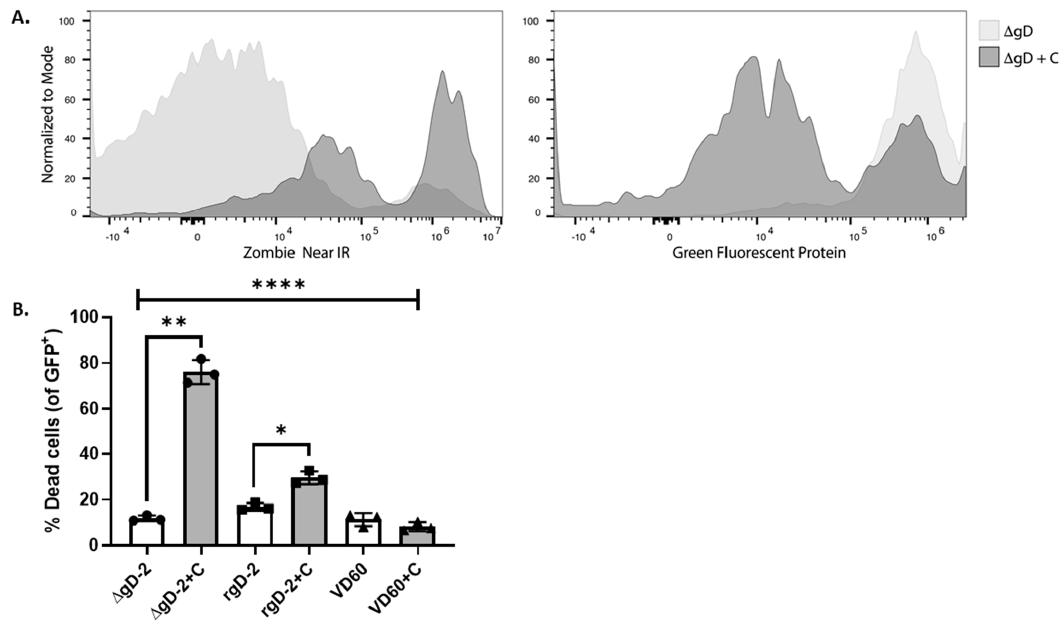
Figure 3. ∆ gD-2 immune serum activates complement-dependent cytolysis. HaCAT cells were infected with HSV- 2(333)ZAG, which expresses GFP, and then incubated for 4 h with heat-inactivated serum (1:50 dilution) obtained from mice prime-boost vaccinated with ∆ gD-2, adjuvanted recombinant gD-2 (rgD-2), or VD60 control cell lysate with or without the addition of rabbit complement (+C). Cells were stained with Zombie NIR live-dead marker, fixed and then analyzed using flow cytometry to quantify the percentage of infected (GFP+) dead cells. ( A ) Representative histogram showing GFP staining (right) and Zombie NIR live/dead staining (left) when infected cells were incubated with Δ gD-2 immune serum obtained from a single mouse with or without complement. The y-axis is normalized to mode (e.g., the highest peak is set at 100% for each sample). ( B ) Bar graph showing percent of the GFP+ dead cells (mean ± SD) from a representative experiment ( n =3 mice per group) (**** p < 0.0001, ** p < 0.01 and * p <0.05, paired t -test comparing cytolysis with or without complement and two-way ANOVA with Tukey’s corrections for multiple comparisons). Results are representative of 3 independent experiments.